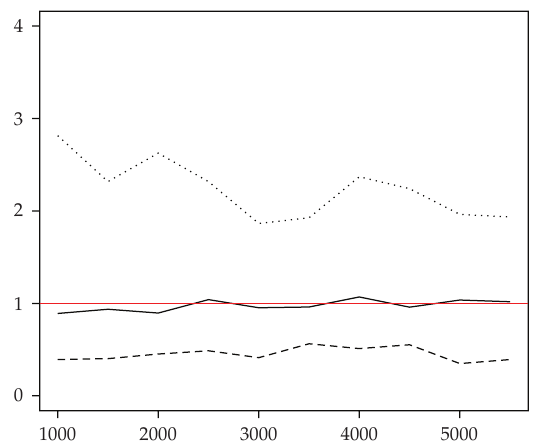
Figure 4: Plots of the ratios of the numbers of extreme statistics, as functions of the sample size, for a stable symmetric distribution S 1 . 2 (cid:2) 1 , 0 , 0 (cid:3) (cid:2) solid line (cid:3) , a stable distribution skewed to the right S 1 . 2 (cid:2) 1 , 0 . 5 , 0 (cid:3) (cid:2) 1 , − 0 . 5 , 0 (cid:3) (cid:2) dotted line (cid:3) (cid:2) dashed line (cid:3) and a stable distribution skewed to the left S 1 . 2